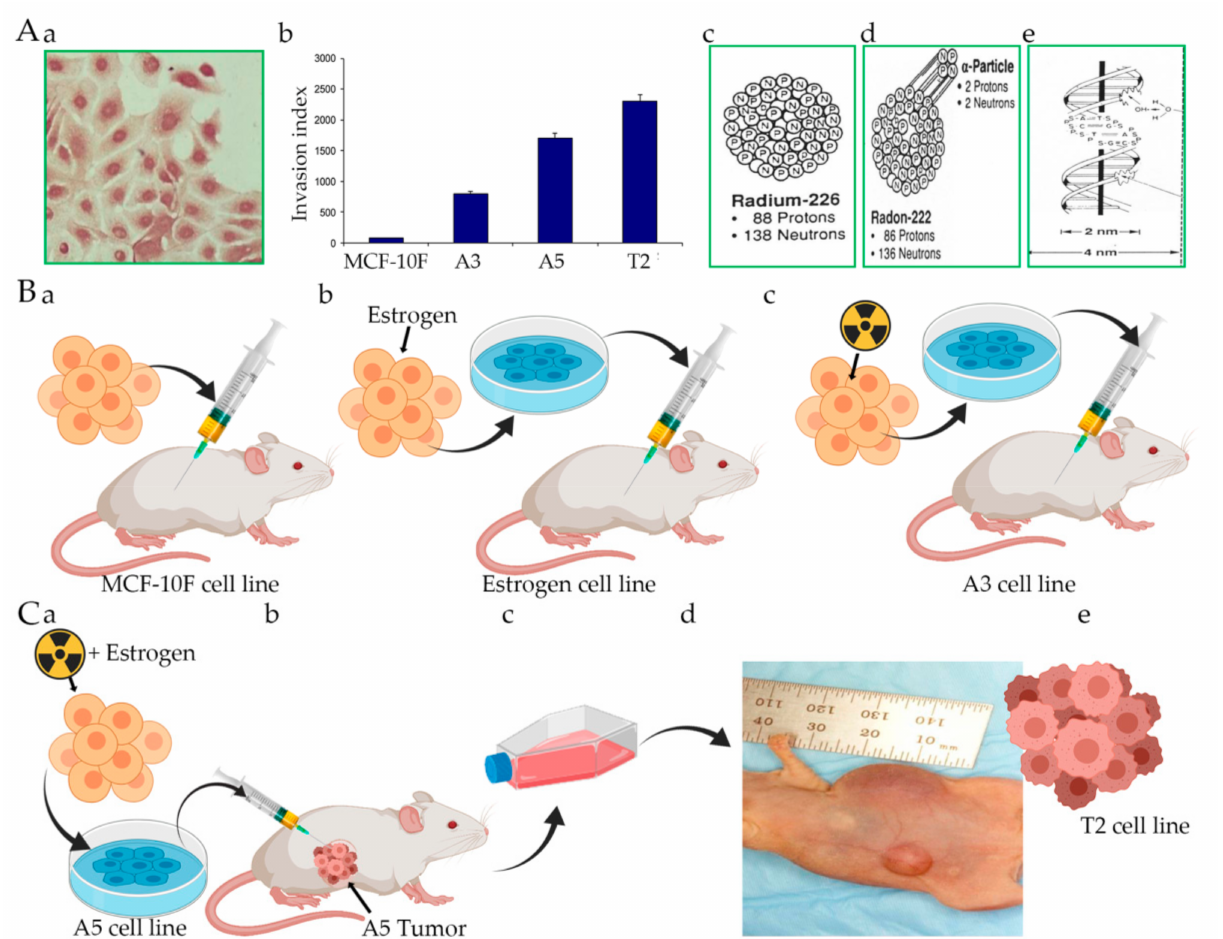
Figure 1. The model consists of human breast epithelial cells in different stages of transformation: (i) parental cell line MCF-10F; (ii) an Estrogen cell line (MCF-l0F continuously grown with estradiol at 10 − 8 (Estrogen); (iii) a malignant and non- tumorigenic cell line (60/60 cGy, named Alpha3), non-malignant cell line (Alpha3); and (iv) a malignant and tumorigenic cell line (60/60 cGy plus estrogen, named Alpha5) and the Tumor2 cell line derived from the nude mouse xenograft of the Alpha5 cell line injected into nude mice. This Figure shows ( A ) ( a ) MCF-10F cell line grown in monolayer; ( b ) Invasion Index with MCF-10F, Alpha3 (A3), Alpha5 (A5) and Tumor2 (T2) cell lines; ( c ) Radium 226, ( d ) Radon 222 and ( e ) scheme of DNA; ( B ) Mouse injected with ( a ) the control, ( b ) Estrogen, ( c ) A3. ( C ) ( a ) A5 cell line (radiation + estrogen); ( b ) Mouse injected with A5 cell line, ( c ) T75 flask with cultured A5 cell line; ( d ) Athymic mouse that shows mammary tumor, giving rise to ( e ) T2 cell